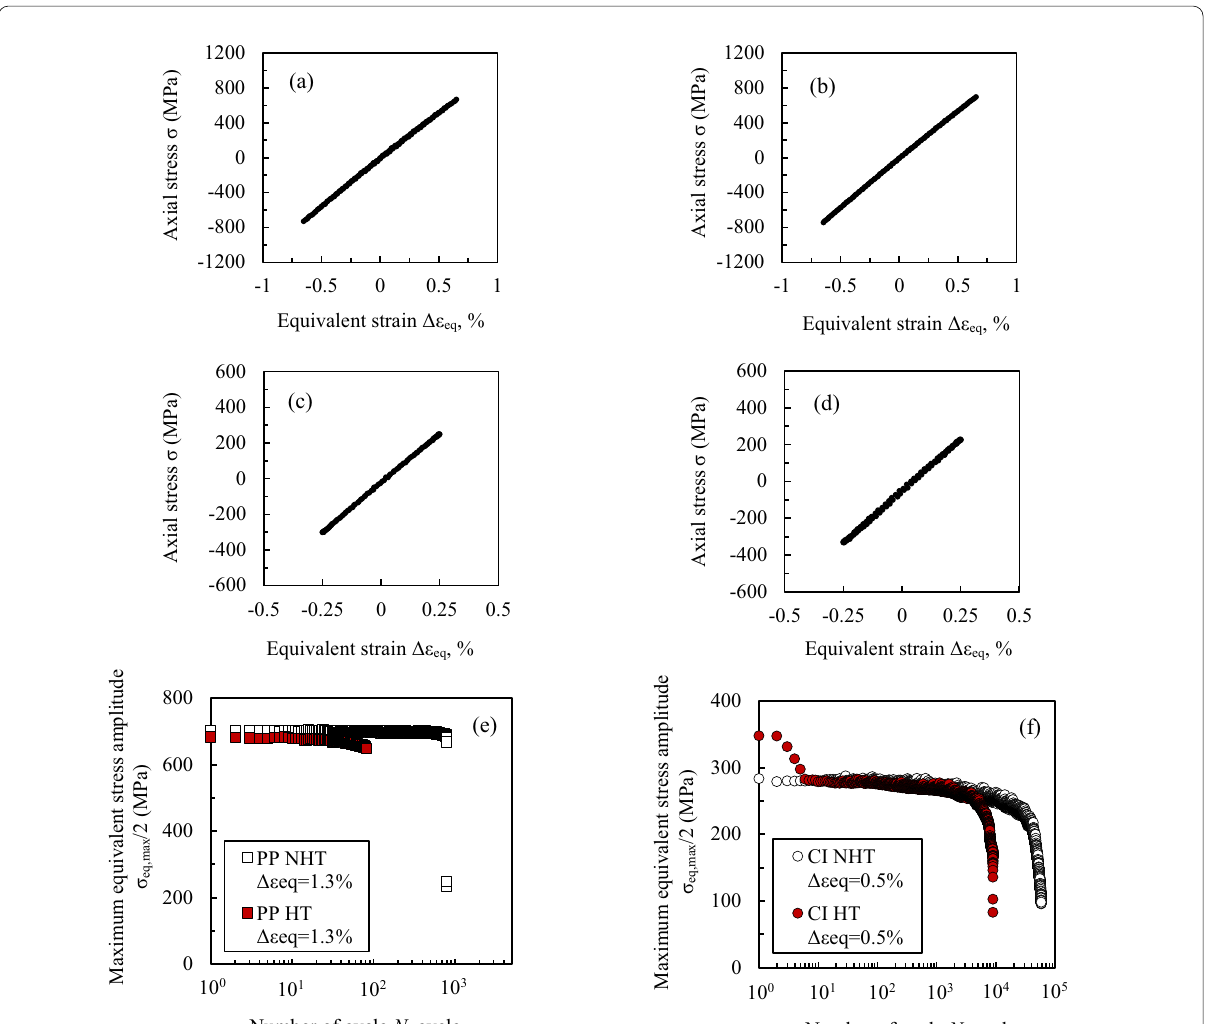
Figure 8 Hysteresis loops obtained at 0.5 N f for Δε eq for Δε eq 1.3% of e PP path, maximum stress for Δε eq =